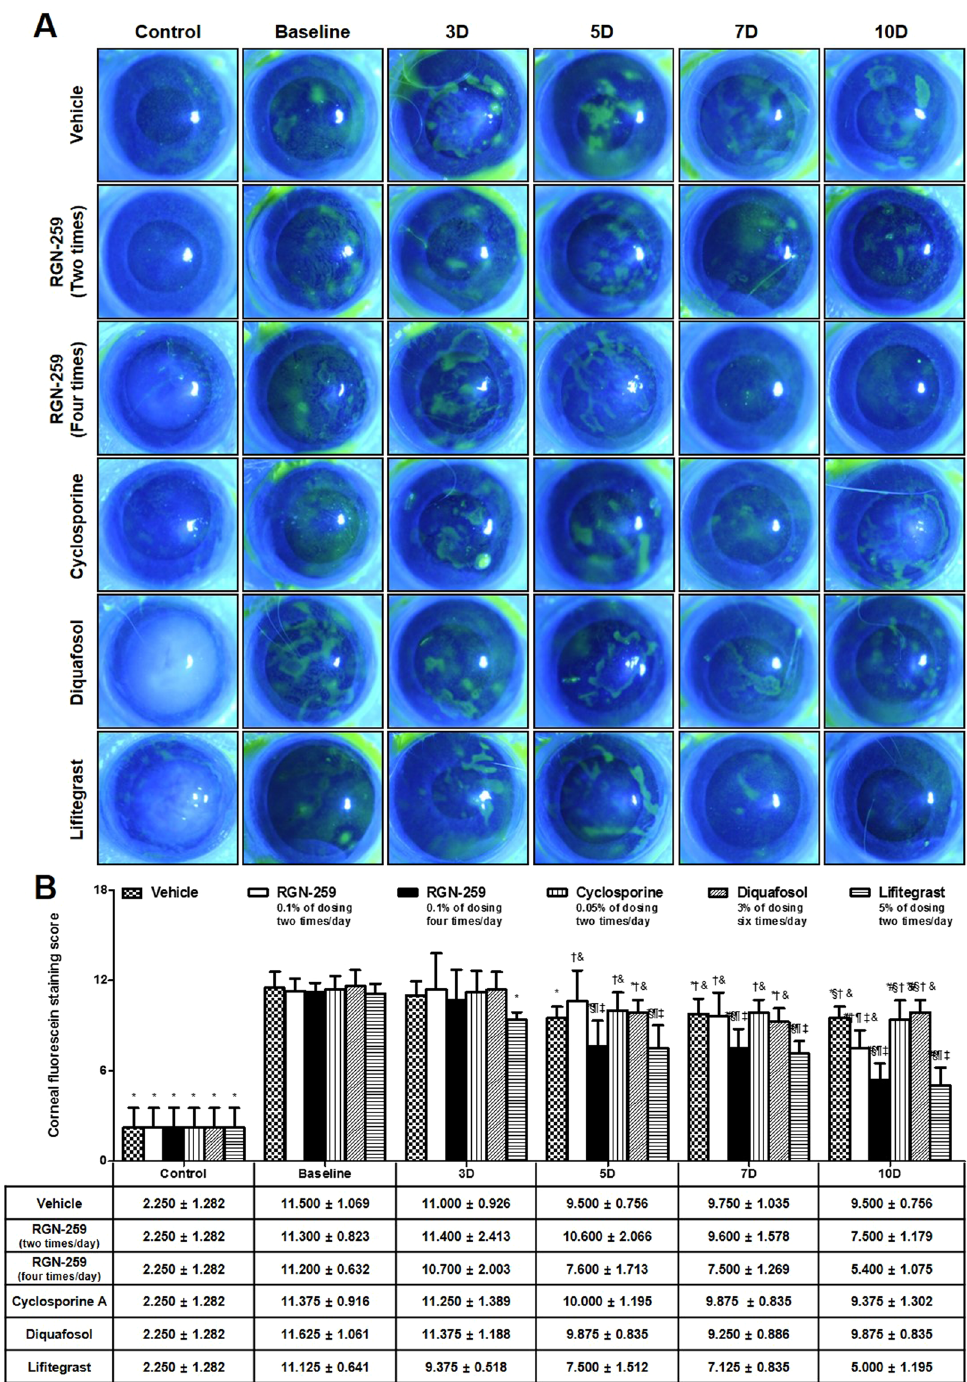
Figure 3. RGN-259 reduced corneal fluorescein staining comparable to that of LFA. ( A ) Corneal fluorescein staining was imaged using a slit lamp biomicroscope. ( B ) Change in the corneal fluorescein staining scores. * P < 0.05 vs. the corresponding value in the baseline desiccation stressed group. # P < 0.05 vs. the value in the vehicle-treated group. § P < 0.05 vs. the value in the RGN-259, 2 times per day group. † P < 0.05 vs. the value in the RGN-259, 4 times per day group. ¶ P < 0.05 vs. the value in the CsA group. ‡ P < 0.05 vs. the value in the DQS group. & P < 0.05 vs. the value in the LFA